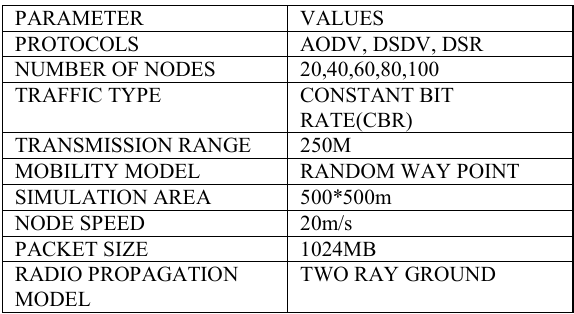
Scenario2:- The nodes are moving with a constant speed of 20m/s. The simulation time is taken to be 600ms. The number of nodes are varying from 20, 40, 60, 80 and 100 with constant packet sie of 1024Mb.